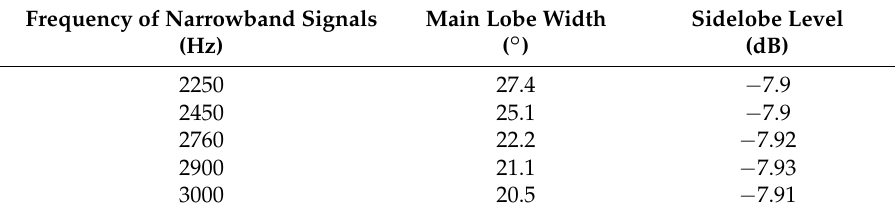
Table 2. Comparison of beamforming parameters for broadband